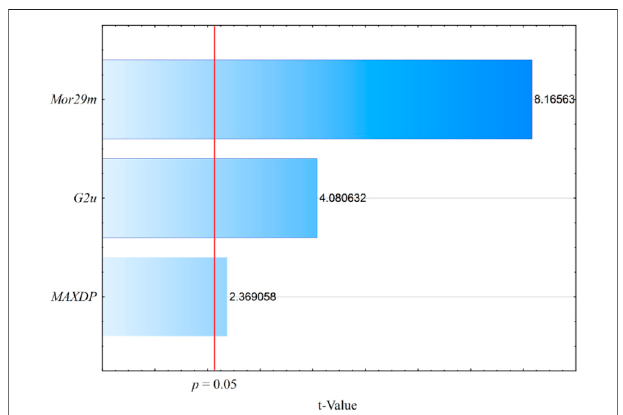
FIGURE 2 | Chart of each descriptor t-values in the model